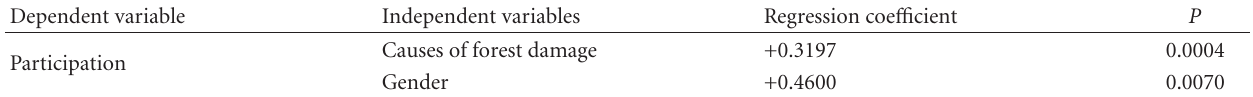
Table 4: Comparisons of means for the selected variables a ff ect the dependant variable (respondents’ attitude towards tree). Independent variables No. of sample Sum of squares Df Mean square F Sig Family uses 100 7.97 1 7.97 9.92 0.002 Age 100 13.52 2 Table 5: E ff ect of age and cause of forest damage on respondents’ participation. Dependent variable Independent variables Participation